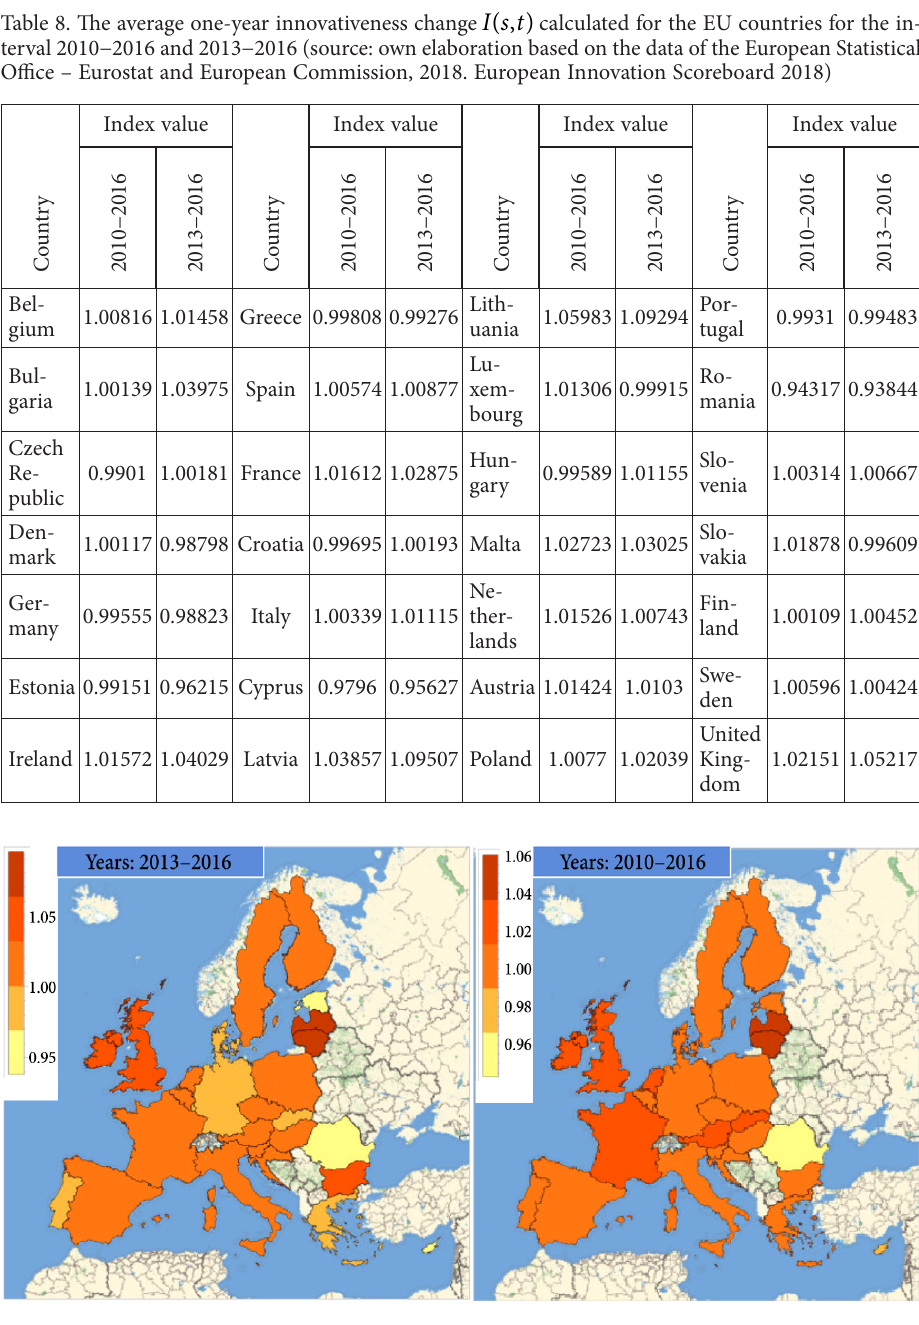
Figure 5. The one-year innovativeness changes in the EU countries for two selected time periods (source: own elaboration based on the data of the European Statistical Office – Eurostat and Euro- pean Commission, 2018. European Innovation Scoreboard,